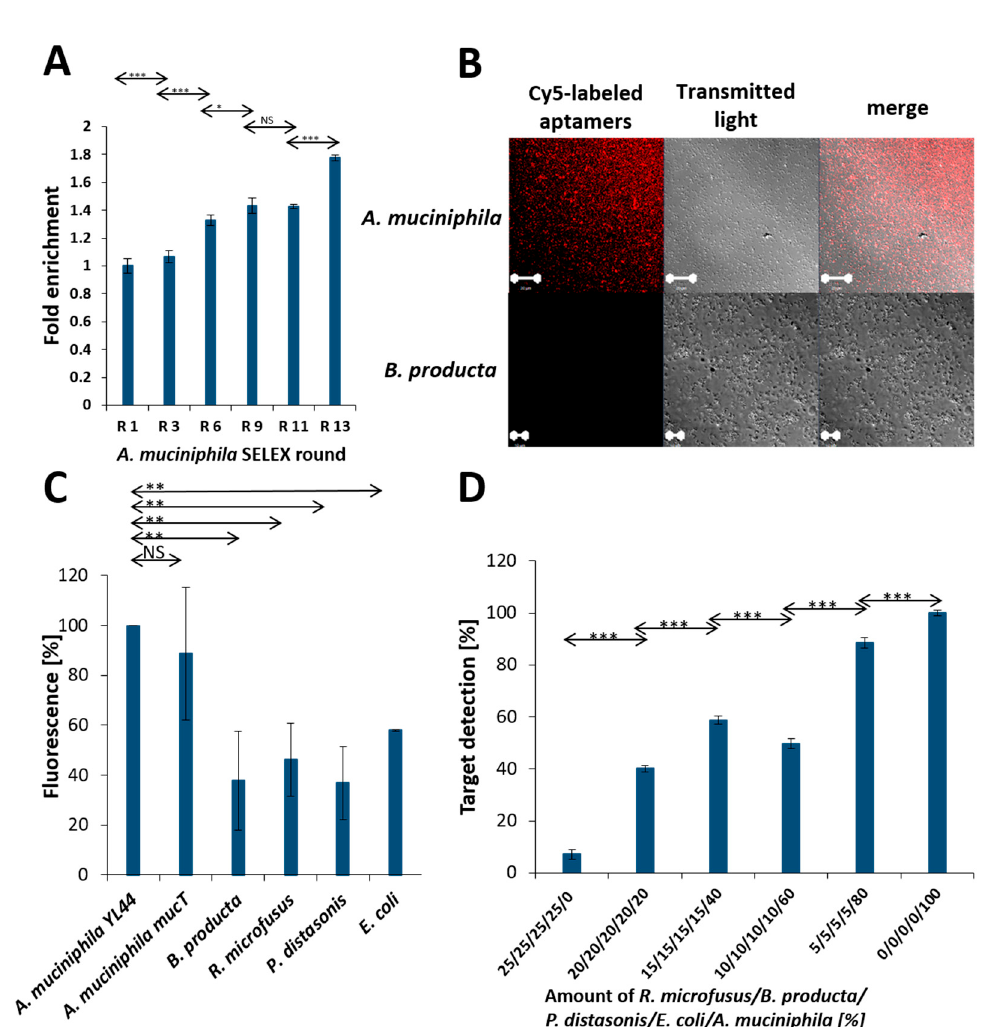
Figure 2. Binding and specificity of a polyclonal aptamer library selected against A. muciniphila . ( A ) Binding assay of fluorescently-labeled aptamer libraries at equal concentrations and washing with PBS. The fractions eluted from cells by heat show an increasing fluorescent signal, demonstrating the enrichment of specific aptamers. ( B ) Confocal laser scanning microscopy of aptamer labeled A. muciniphila cells. The fluorescently labeled polyclonal aptamer library was sufficient to label Akkermansia cells in situ. Blautia producta served as a control and did not display any colocalization of the aptamer with the cells. ( C ) Increased specificity of the polyclonal aptamer library toward A. muciniphila compared to the microbiome control organism. ( D ) The polyclonal library is sufficient to retrace the amount of A. muciniphila in a complex mixture including the gut microbiome control bacteria B. producta , R. microfusus , P. distasonis and E. coli were adjusted to equal optical densities and mixed at different volume ratios. Statistical analysis by a t test was performed for the enrichment of specific aptamers and the specificity of the polyclonal library. p values < 0.05 were considered significant. * denotes p < 0.05, ** p < 0.01 and *** p < 0.001. The experiments were performed in triplicate and standard deviations are given as error bars. When individually not visible, the deviation was too small to be marked by the graphic